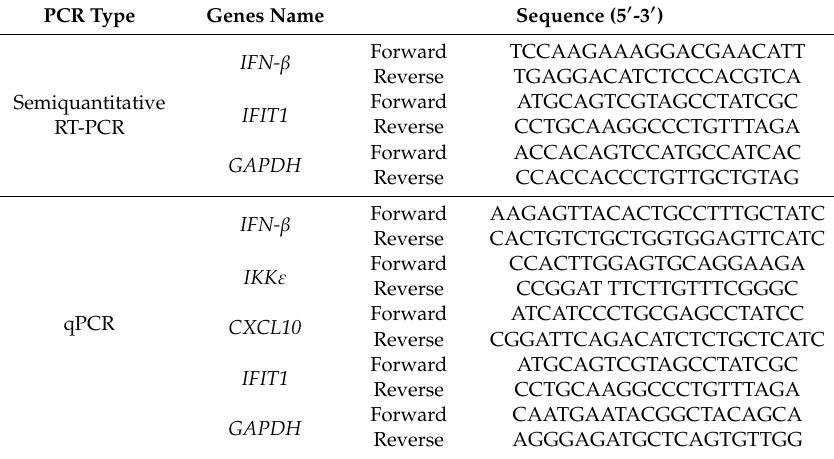
Table 1. Primer sequences used for